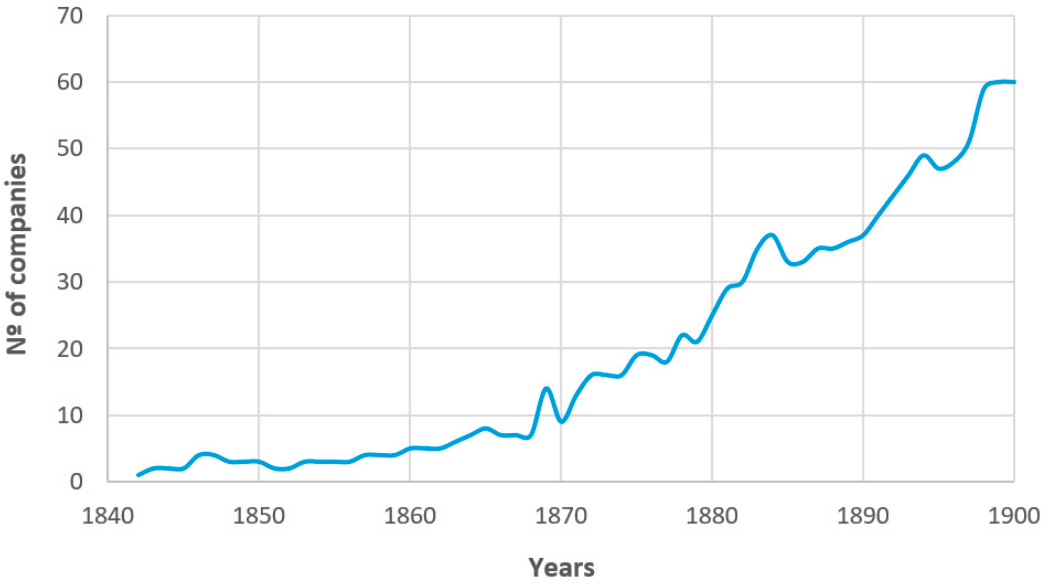
Figure 3. Evolution of the number of water companies from 1842 to 1900.